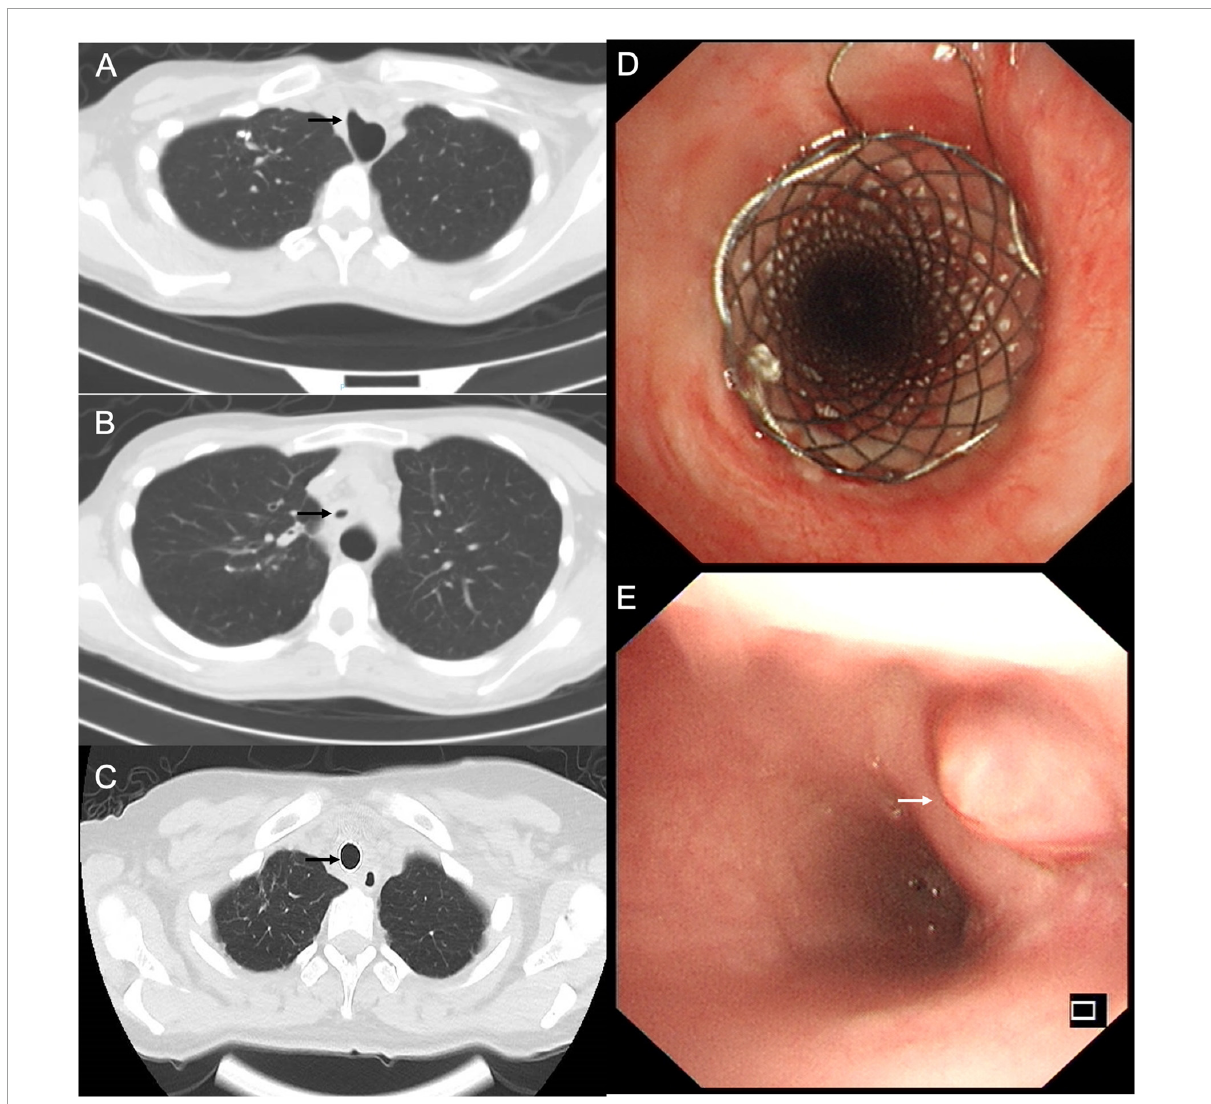
FIGURE3 (A) The chest computed tomography (CT) showed the tracheoesophageal fistula (TEF) in the trachea (black arrow). (B) The chest CT performed after the stent removal demonstrated a diffuse tracheal stenosis, the narrowest part being 5.7 mm in diameter (black arrow). (C) Axial chest CT view confirmed the closure of TEF and patency of the trachea (black arrow). (D) The fully covered self-expandable metallic stent extended more than 10 mm beyond the TEF to occlude the orifice and establish the patency of the tracheobronchial tree. (E) The endoscopic view of TEF was fully covered by epithelium and granulation tissue (white